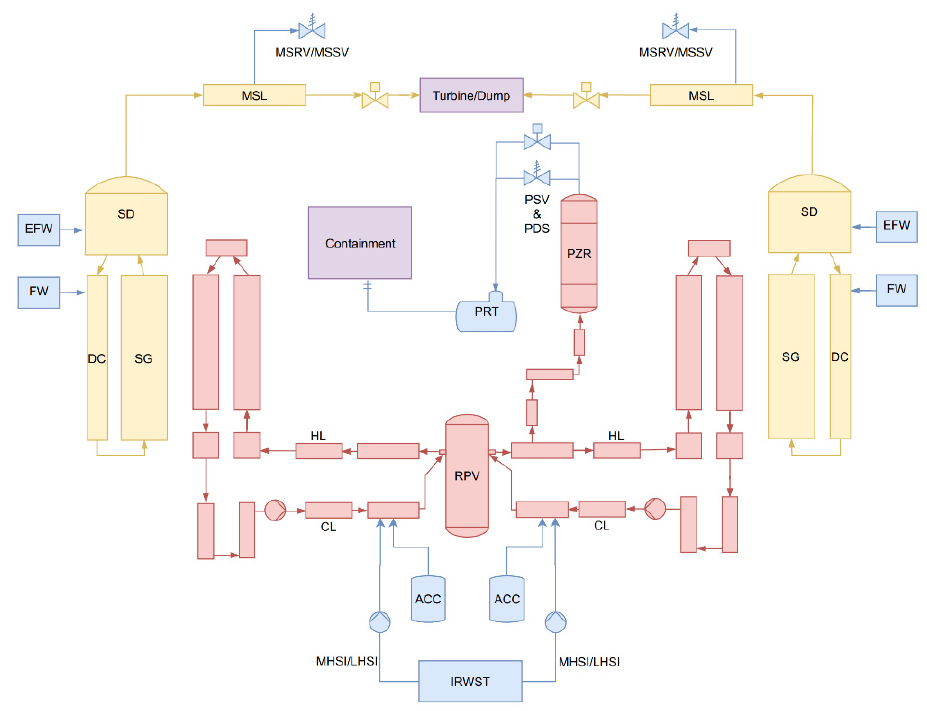
Figure 4. RCS model, including CVH, COR, and HS package models. ACC—accumulator, IRWST— in-containment refueling water system tank, HL—hot leg, CL—cold leg, SG—steam